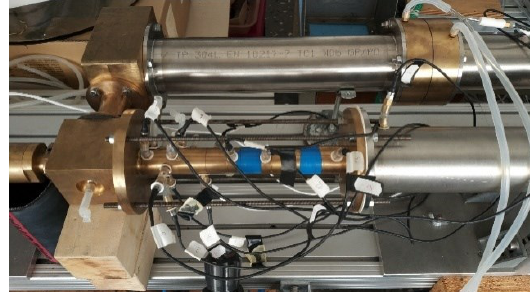
Fig. 7. Ejector assembly with pressure sensors